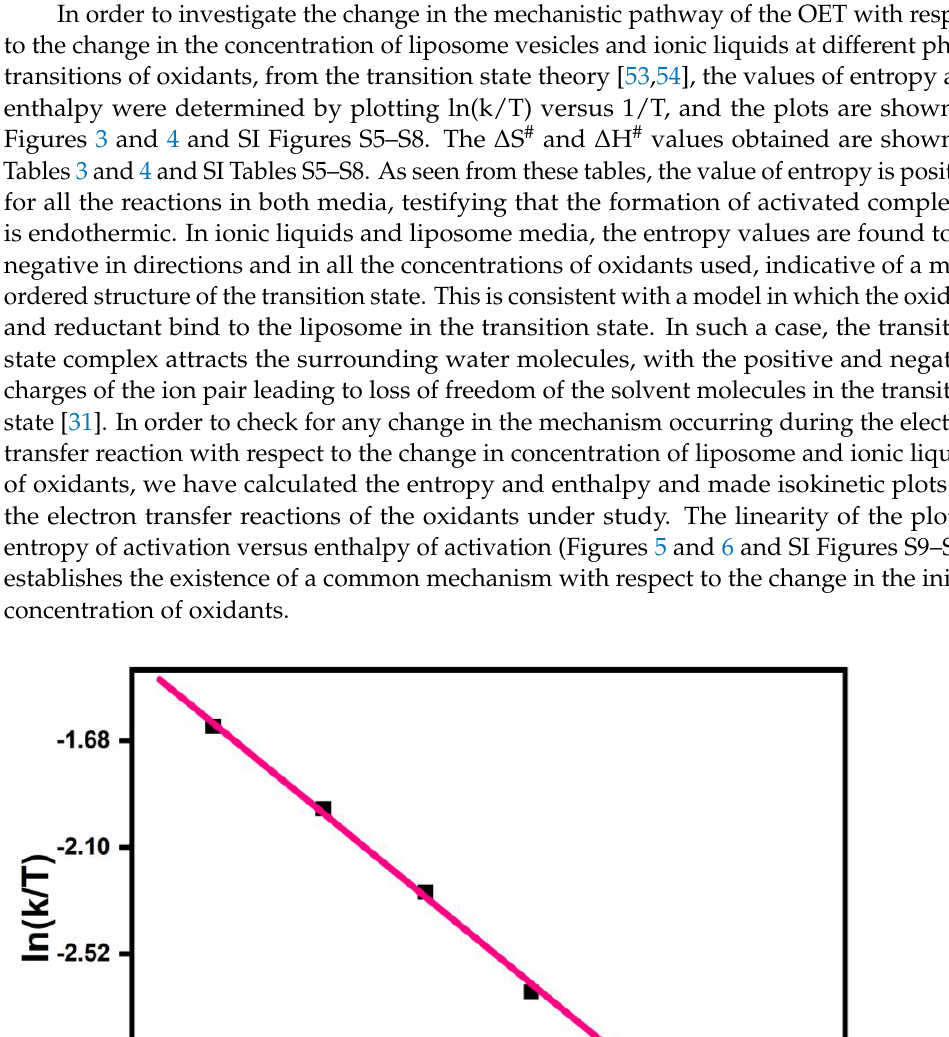
Table 3. Activation parameters for the reduction of cis-[Co(ip) 2 (C 12 H 25 NH 2 ) 2 ](ClO 4 ) 3 , μ = 1.0 moldm − 3 in DPPC medium.